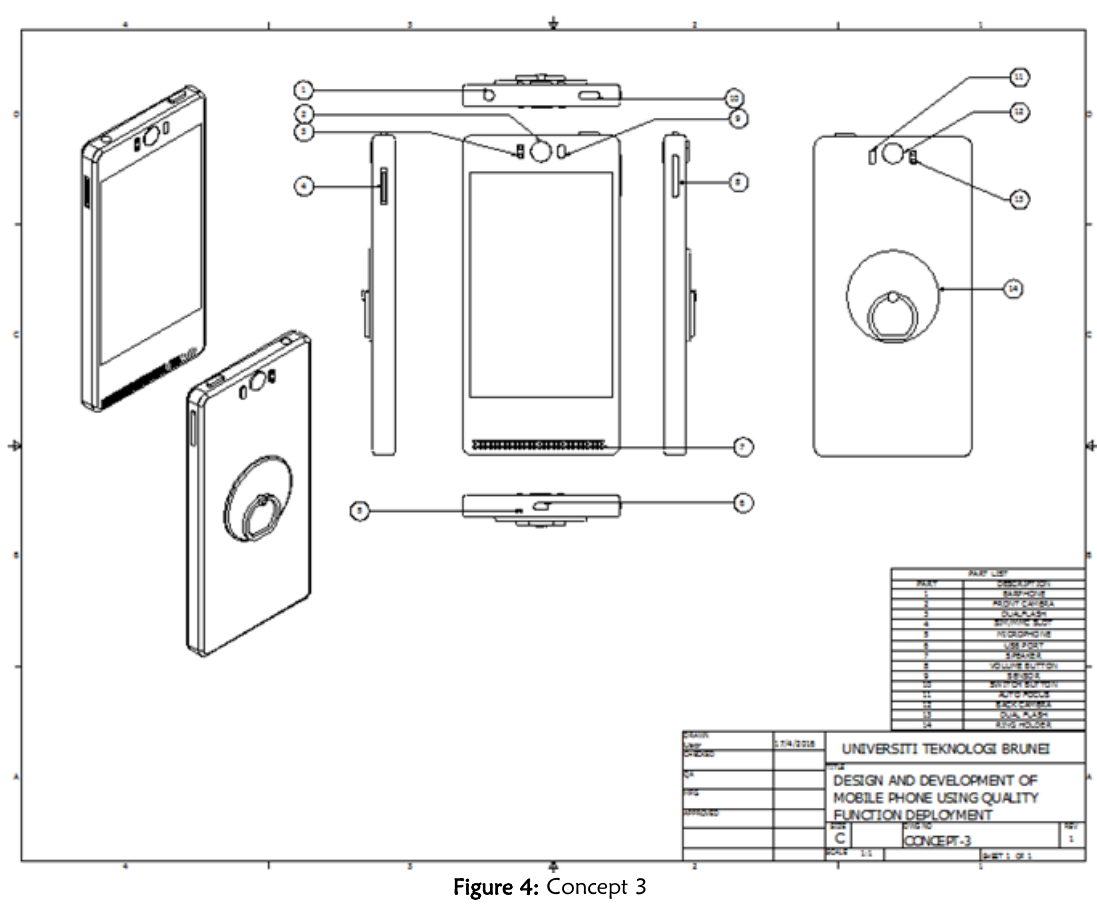
Figure 4: Concept 3